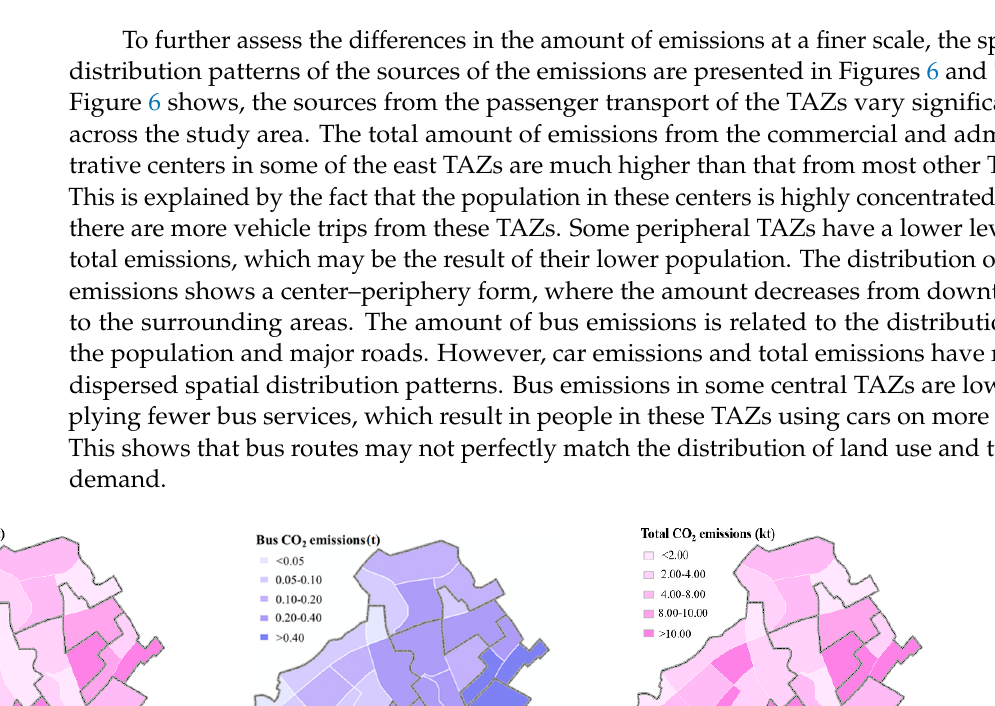
( c ) Figure 7. Spatial distribution of the sources of the per capita emissions of each TAZ. ( a ) Car CO 2 emission per capita; ( b ) bus CO 2 emission per capita; ( c ) total CO 2 emission per capita.